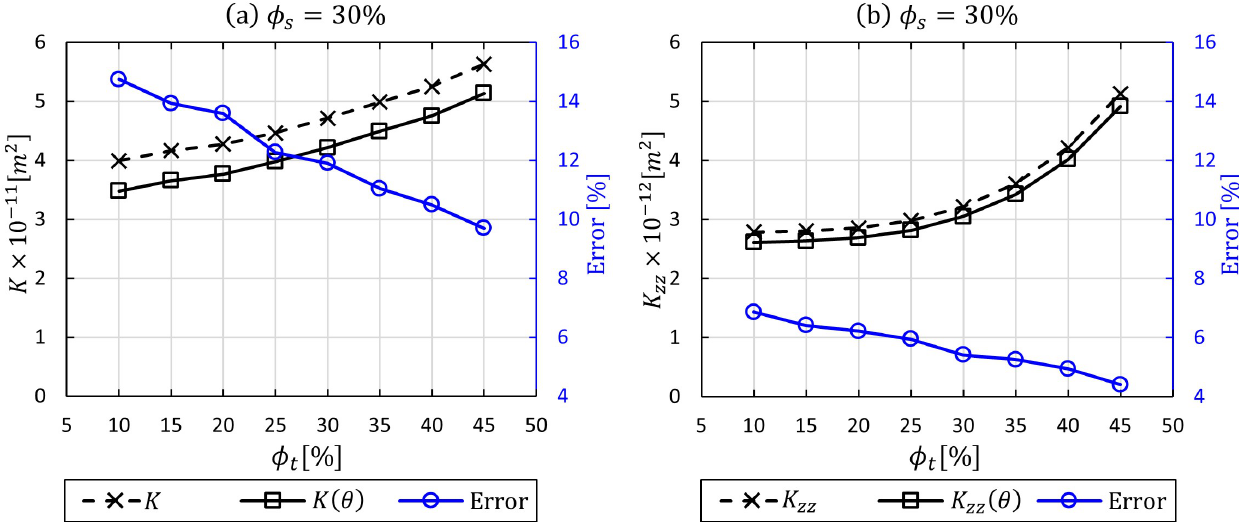
Figure 9. A comparative analysis of permeability with and without applying local curvature (0 ≤ θ ≤ 35) via UDF for permeable tows at inter-tow porosity ( φ s = 30%) with various φ t values: ( a ) in-plane permeability, ( b ) through- thickness permeability.